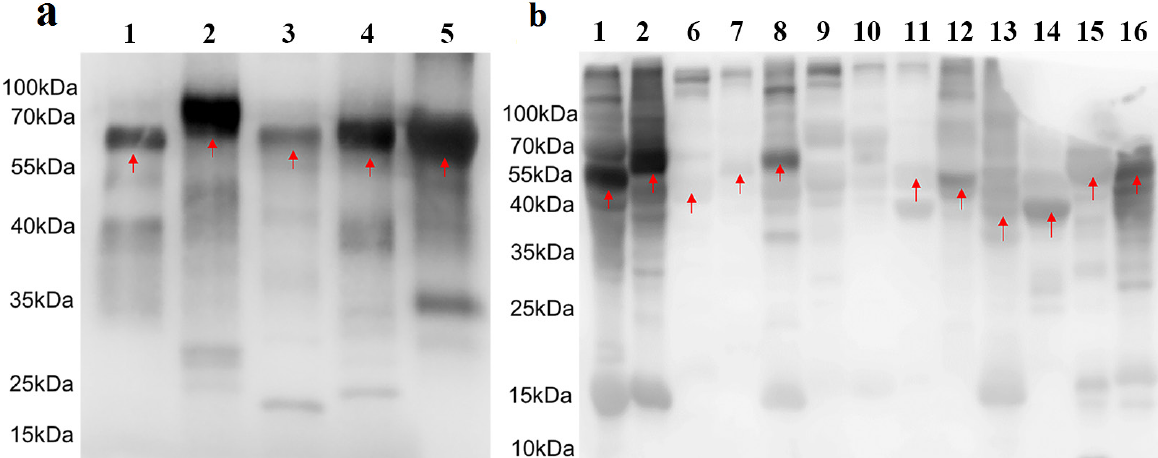
Figure 4. Sera from different fishes reacted with purified rabbit IgG anti-fish IgMs by western blotting. (a) Rabbit IgG anti-fish IgMs probed with sera from five categories of fishes from which fish Ig M were acquired. Lane 1: grass carp, Lane 2: crucian carp, Lane 3: bighead carp, Lane 4: common carp, and Lane 5: tilapia. (b) Rabbit IgG anti-fish IgMs reacted with sera from other 11 categories. Lane 6: Japanese sea perch, Lane 7: sunfish, Lane 8: Oshima, Lane 9: mandarin fish, Lane 10: Linnaeus, Lane 11: snakehead, Lane 12: yellow catfish, Lane 13: bream, Lane 14: black pacu, and Lane 15: black bream, Lane 16: silver carp. The arrows indicated H chains of